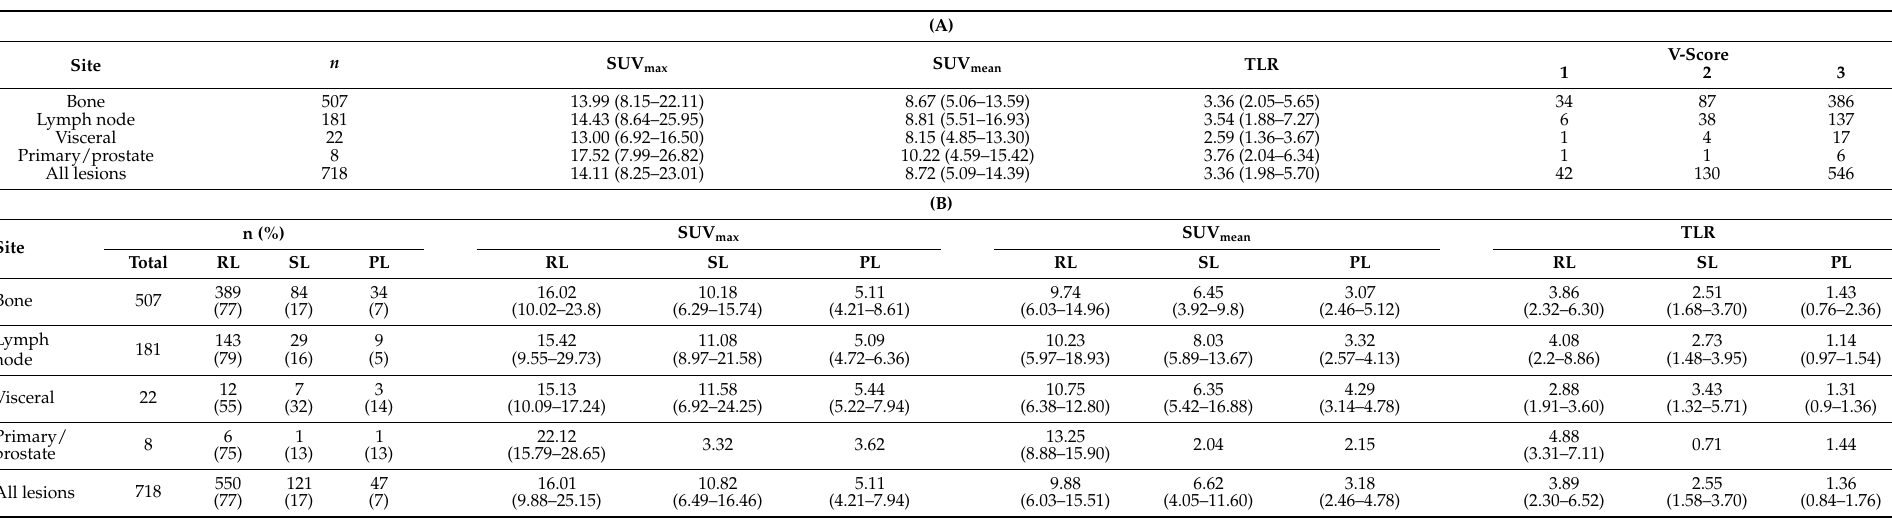
Table 2. Baseline characteristics of lesions (A), stratified by response (B). Data presented with median and interquartile range (IQR) or n (%). RL: responding lesions, SL: stable lesions, PL: progressive lesions, SUV: standardized uptake value, TLR: tumor-to-liver